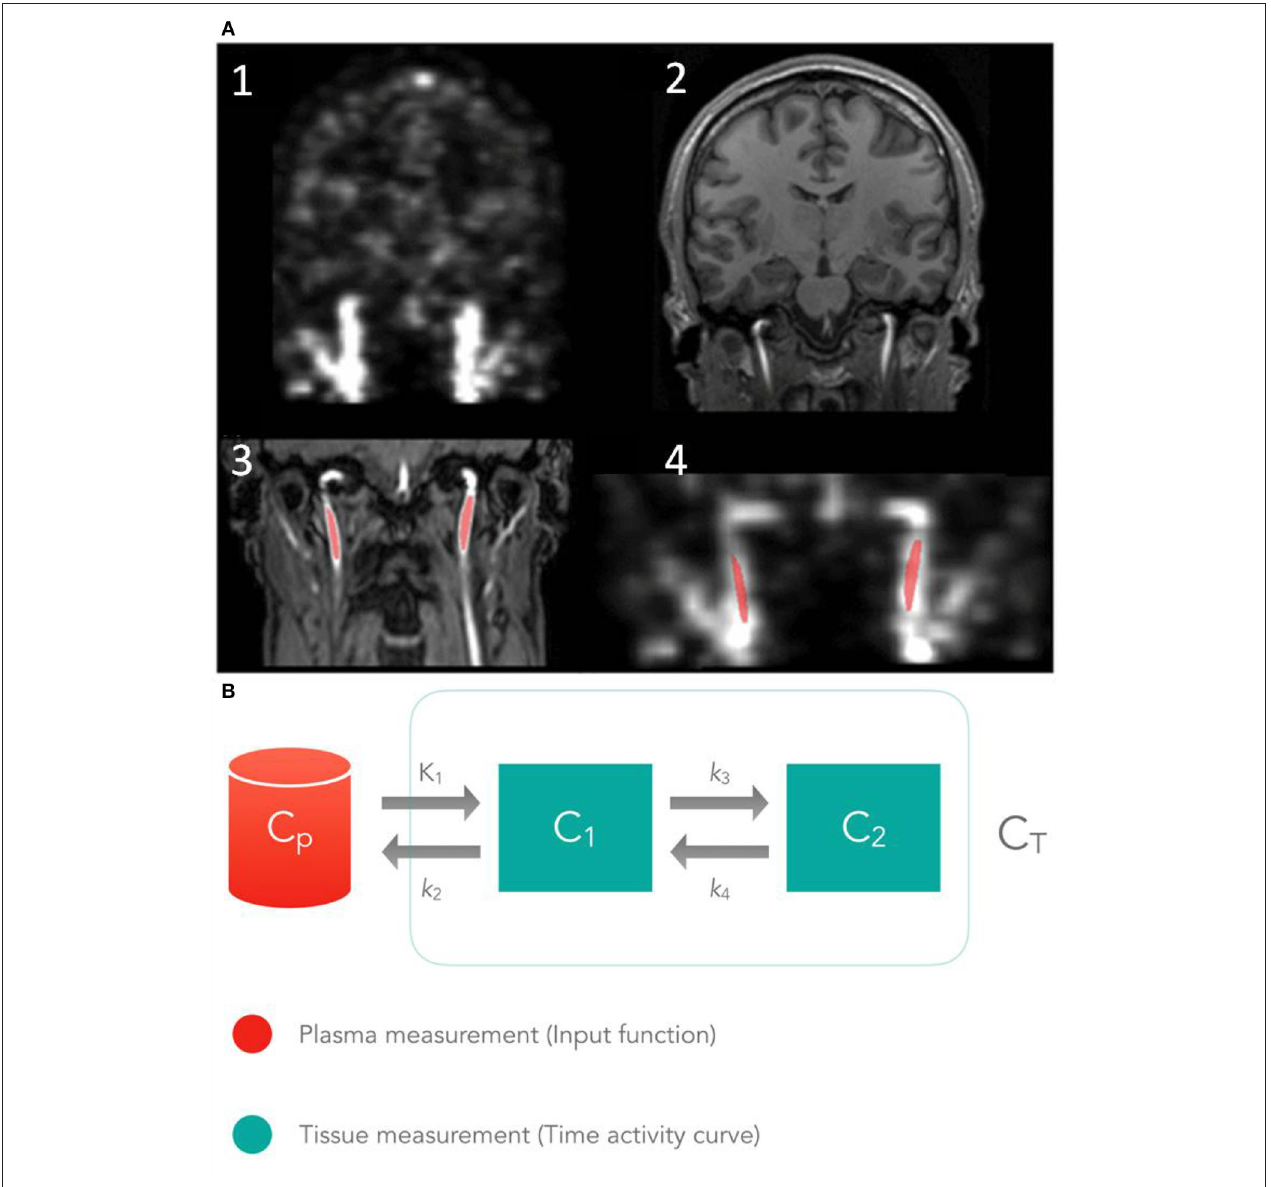
FIGURE 7 | Schematic view of the IDIF concept. (A) 1- PET coronal view showing the carotid arteries, 2- T1-MPRAGE image, 3- TOF MR angiography image of neck region used to segment the carotid arteries, 4- PET coronal view co-registered with the segmented carotid arteries. (B) Illustration of the 2-tissue compartment model commonly used for FDG tracer kinetics. Here, C P represents the blood activity and C 1 , C 2 the activity concentration of each tissue over time t. K1, k2, etc., are the rate constants that define the rate of tracer movement between compartments. This figure was adapted from Sari et al. [228], with permission of SAGE Publications,